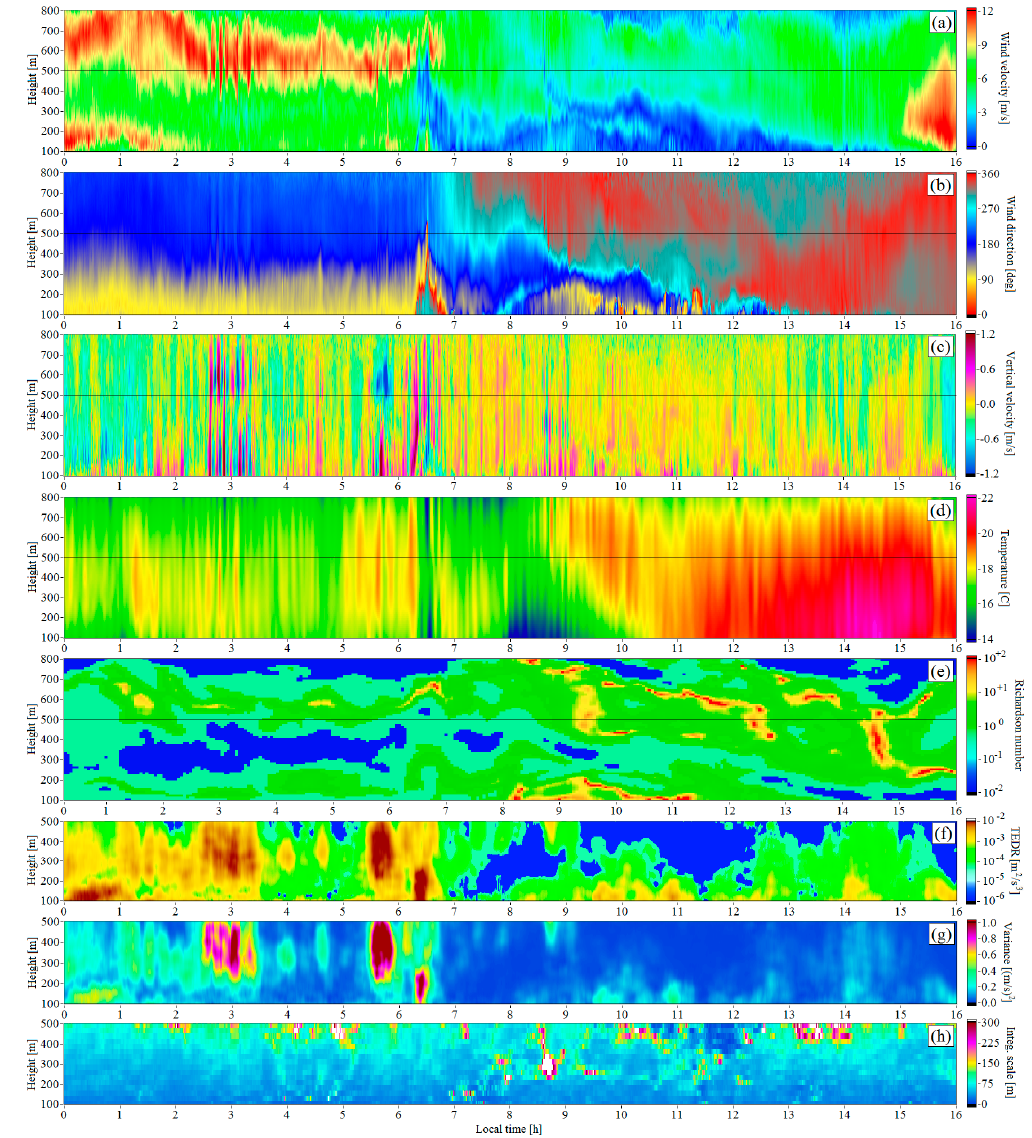
Figure 10. Height–temporal distributions of wind velocity ( a ), wind direction angle ( b ), vertical component of wind velocity ( c ), air temperature ( d ), Richardson number ( e ), turbulent energy dissipation rate ( f ), variance of radial velocity ( g ), and integral scale of turbulence ( h ), as obtained from the data of the measurements by the lidar and by the profiler on 23 August 2018.